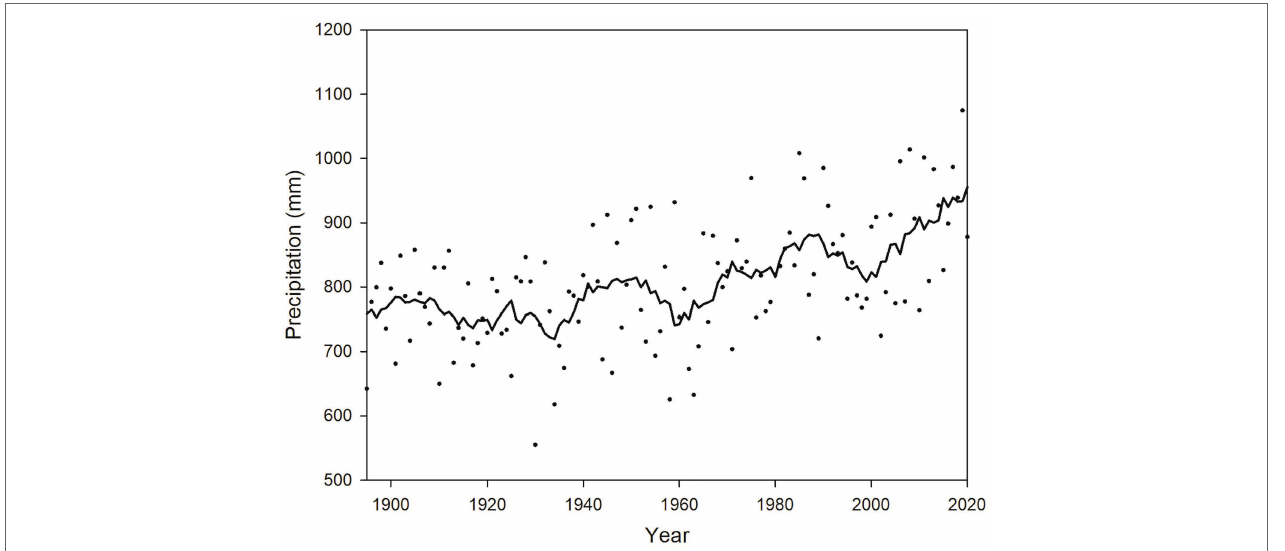
FIGURE 3 | Annual total precipitation (mm) spatially averaged across the Lower Peninsula of Michigan, 1895–2020 (depicted by dots). A 9-year, uniformly weighted moving average is given by the solid black line. Data are based on the NOAA NCEI Climatological Division data series (NOAA NCEI,